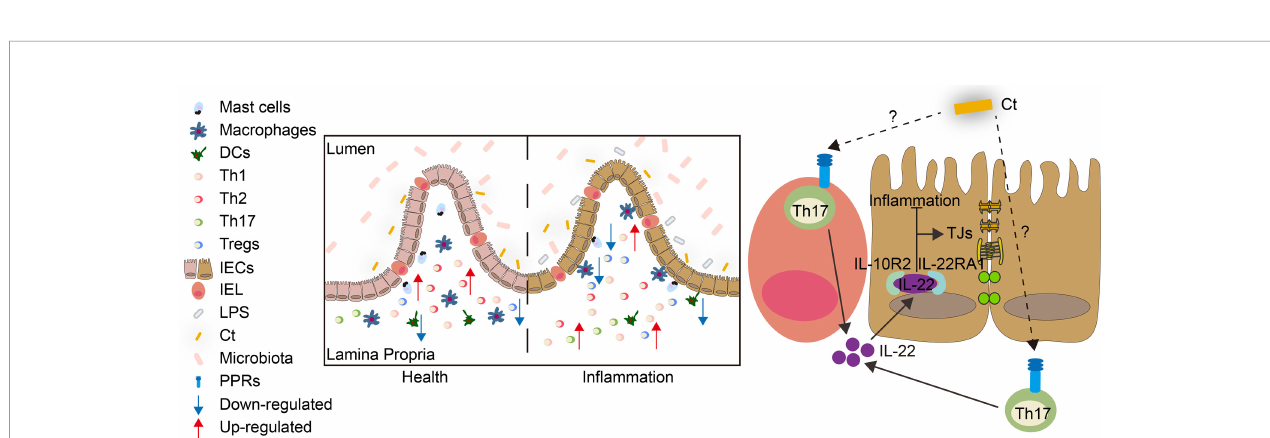
FIGURE 8 | Ct decreases the ileal levels of SCFAs in response to LPS. Data were presented as mean ± SEM (n=6). The signi fi cant difference was analyzed by two- way unpaired t-tests. * P < 0.05, ** P < 0.01.